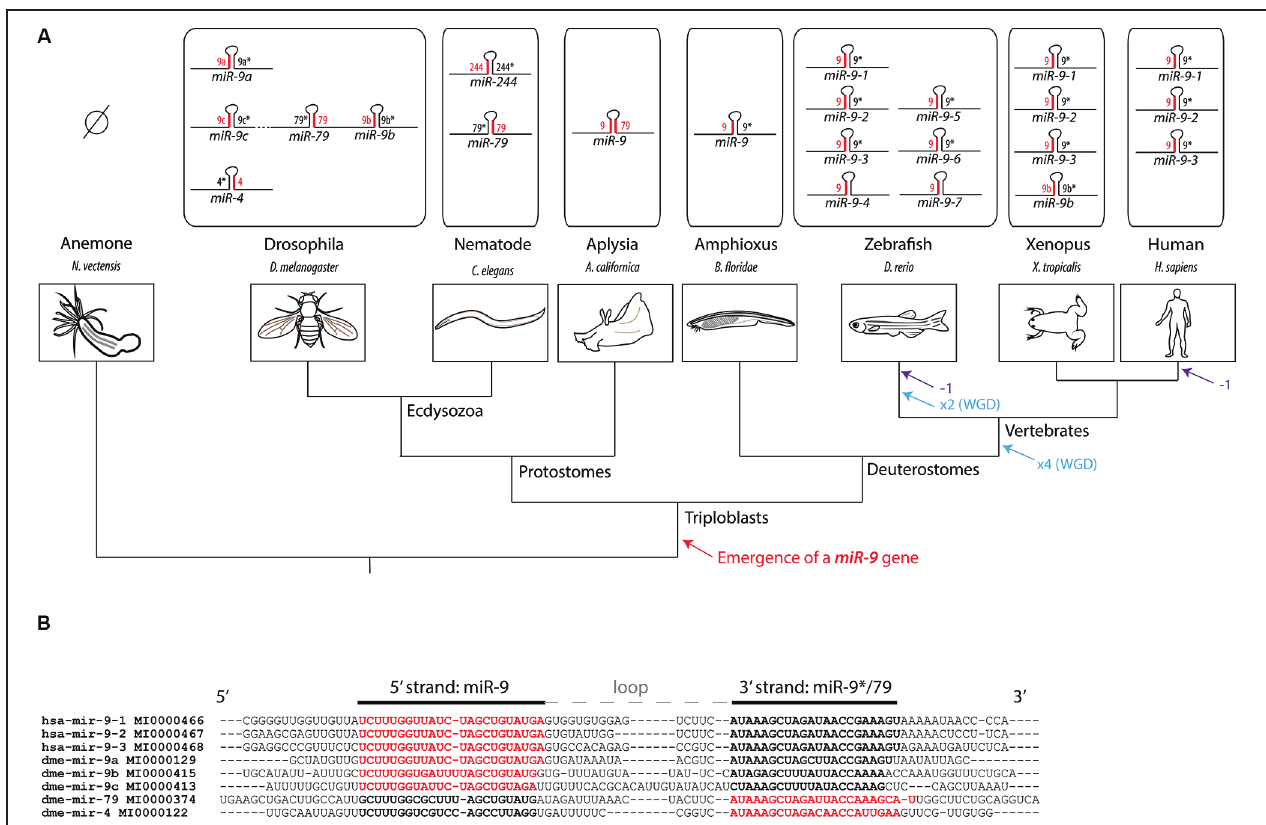
genome duplications (WGD) have occurred. An additional WGD occurred in the teleost lineage. These duplication events likely account for the presence of multiple miR-9 genes in vertebrates. Eutherian mammals lost one class of miR-9 genes (corresponding to miR-9-4 , also called miR-9b ). (B) Alignment of pre-miR-9 sequences from Drosophila and human. Sequences, names and reference numbers were retrieved from miRBase. 1 Nucleotides highlighted in bold correspond to the two microRNA strands, with the preferred strand in red, and the non-preferred one in